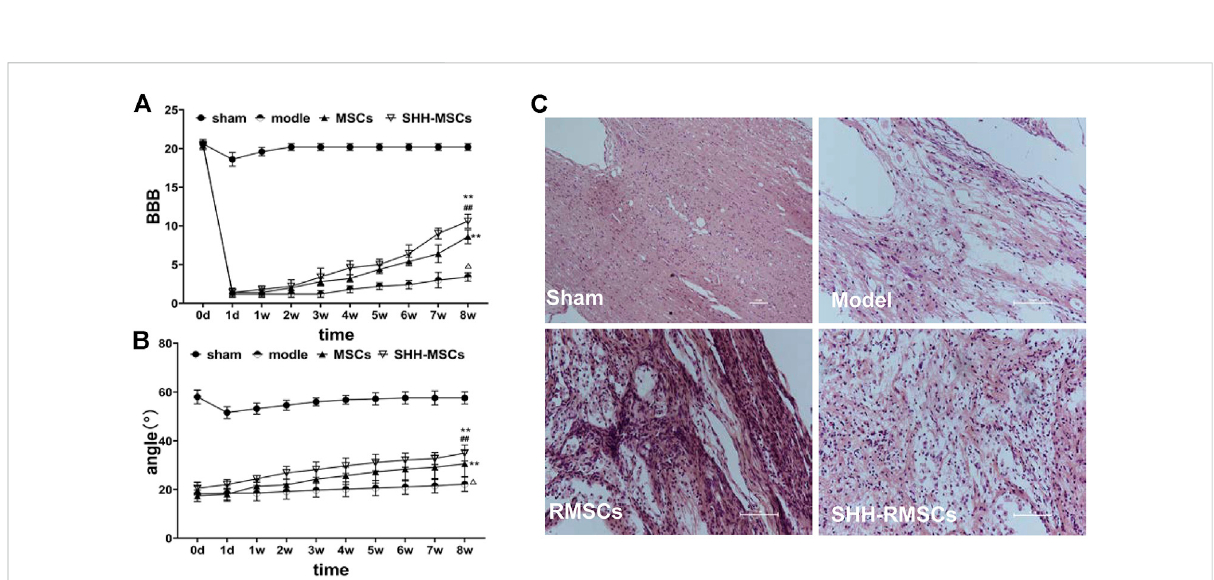
FIGURE 5 (A) and (B) TheBBBscoresandinclinedplateanglesofSCIfor8weeks.TheresultsoftheSHH-RMSCgroupweresigni fi cantlyhigherthanthose ofthemodel,sham, and RMSC,and thedifference wasstatistically signi fi cant (**, p < 0.01, compared with model; ## , p < 0.01, compared withMSCs; Δ , p < 0.01, compared with sham). (C) H&E staining of SCI. SHH-RMSCs group improved signi fi cantly, while the tissue arrangement tended to